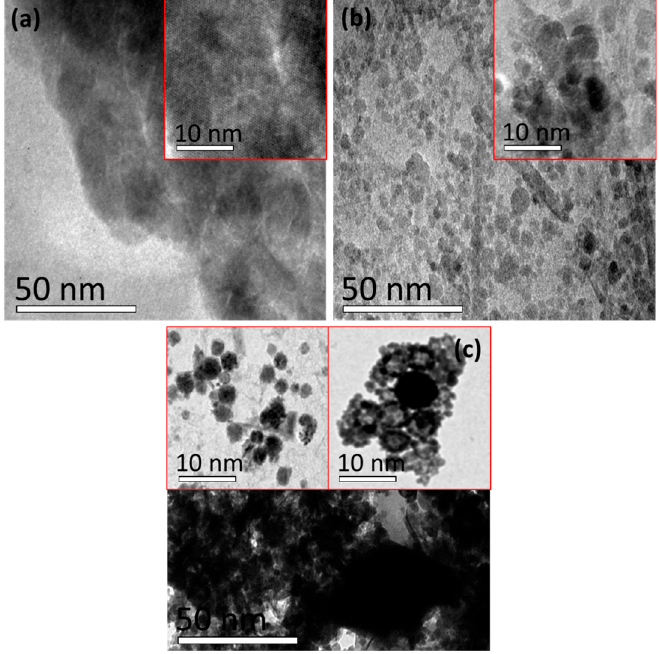
Figure 5. Transmission electron microscopy (TEM) images of ( a ) CS and the ( b ) CS–ZnO and ( c ) CS–ZnO–GO hybrid structures (Inset—corresponding higher magnification TEM images).